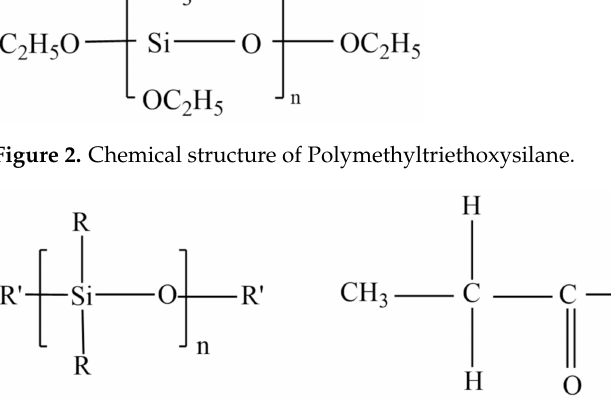
Figure 3. Chemical structure of Silicone acrylic emulsion.